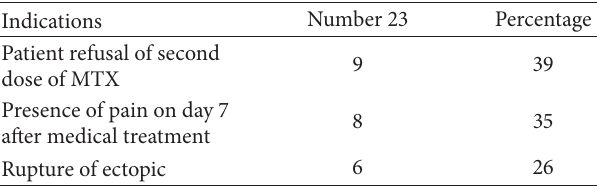
Table 2: Indications for surgical treatment in patient whom failed first dose of methotrexate.